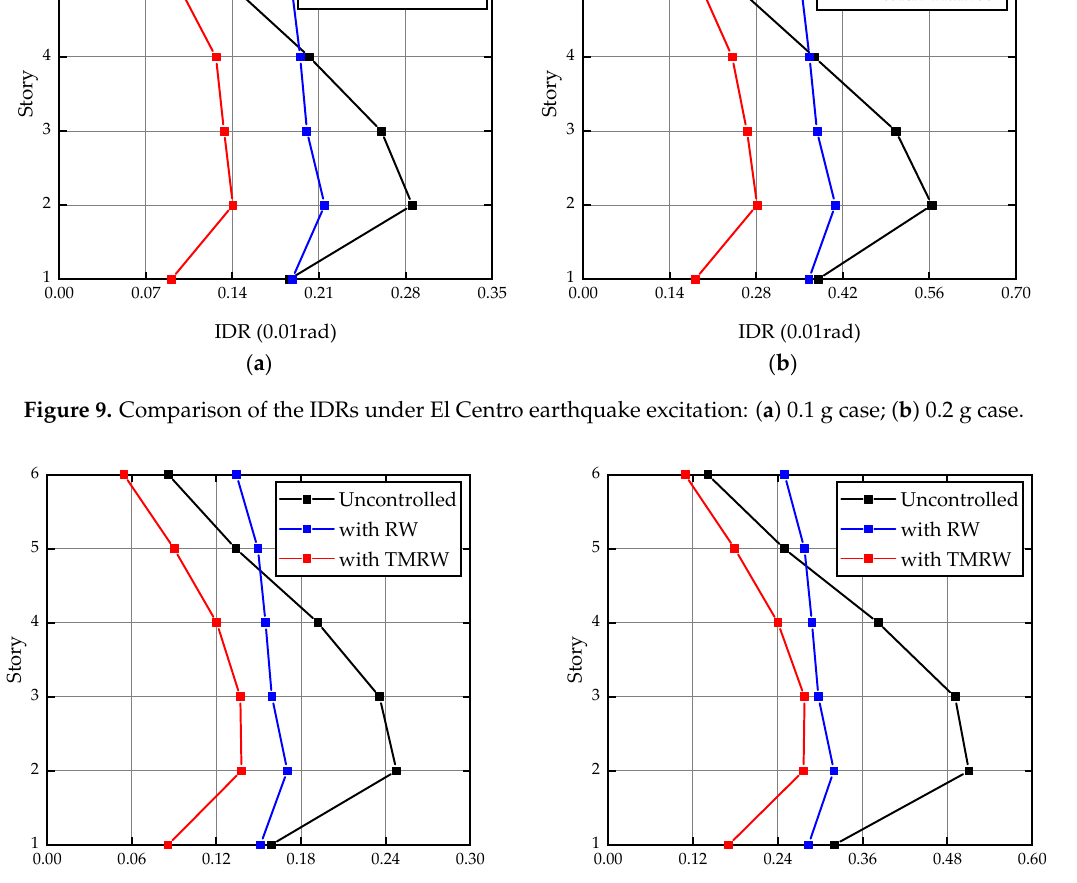
Buildings 2021 , 11 , x FOR PEER REVIEW Figure 10. Comparison of the IDRs under Taft earthquake excitation: ( a ) 0.1 g case; ( b ) 0.2 g case. Figure 10. Comparison of the IDRs under Taft earthquake excitation: ( a ) 0.1 g case; ( b ) 0.2 g case. Figure 10. Comparison of the IDRs under Taft earthquake excitation: ( a ) 0.1 g case; ( b ) 0.2 g case.